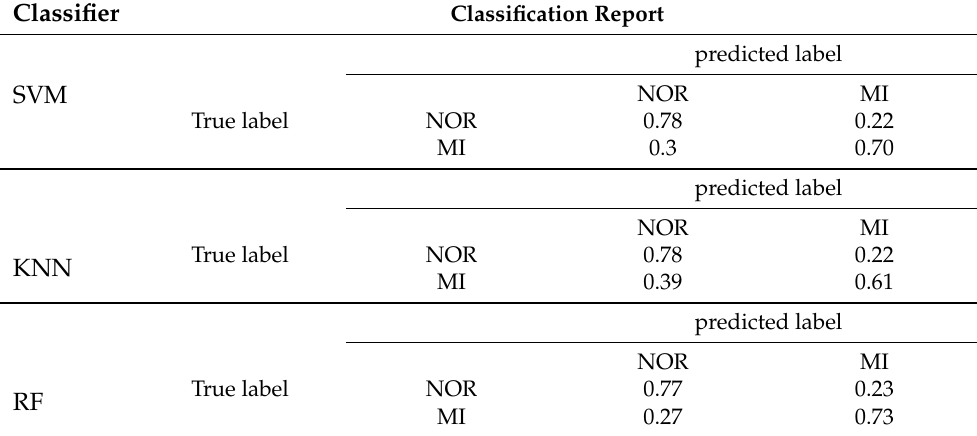
Table 5. Classification